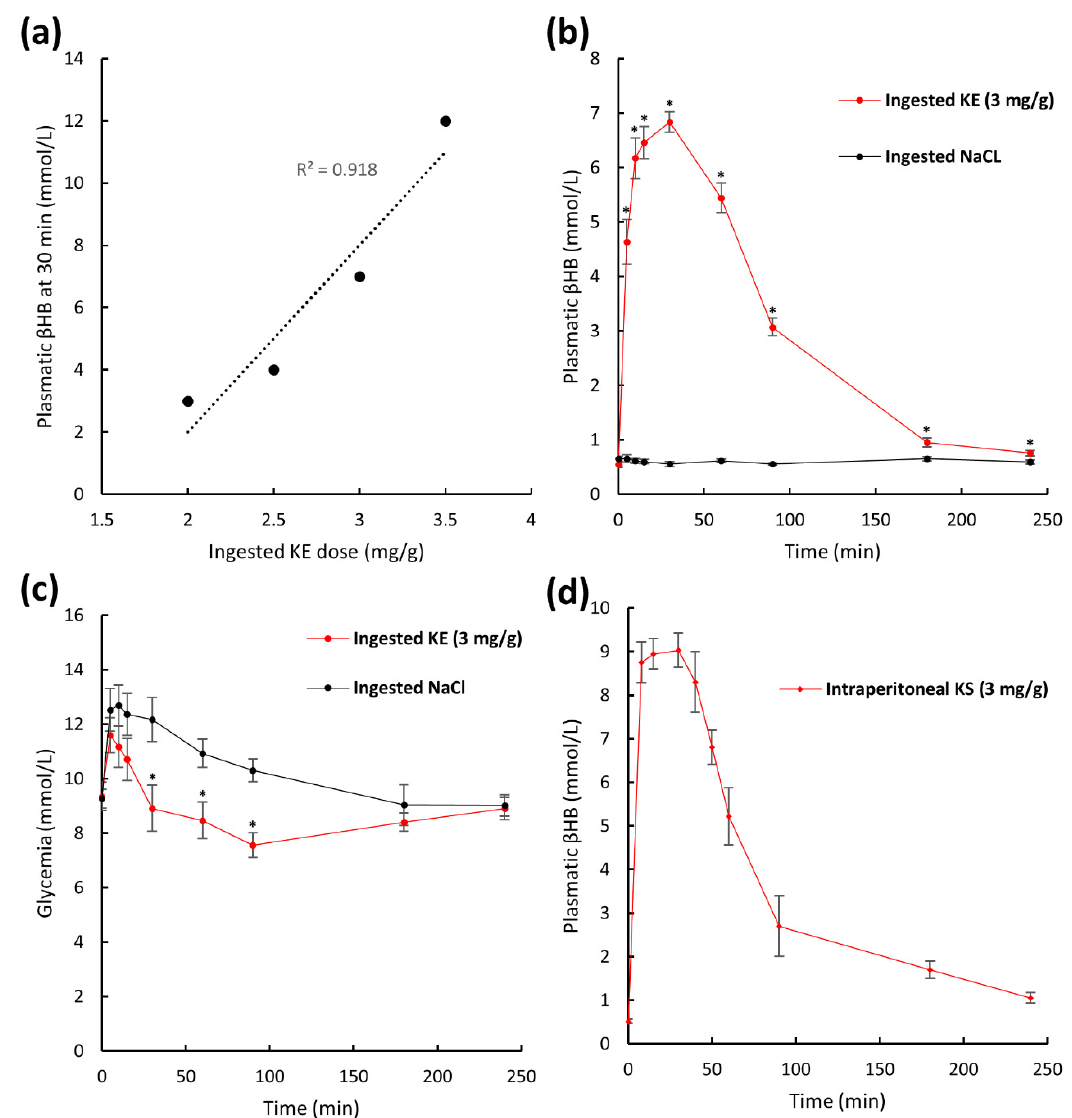
Figure 3. Plasma pharmacokinetics of β -hydroxybutyrate and glucose after KE ingestion. Plasma levels of β HB 30 min after intake of 2, 2.5, 3, and 3.5 mg ketone ester (KE)/g of body weight ( a ). Plasma β HB pharmacokinetics after intake of 3 mg KE/g of body weight or 0.9% NaCl ( b ) and glycemia with the same animals (n = 10) ( c ). Plasma β HB pharmacokinetics of mice after intraperitoneal injection of ketone sodium salt (3 mg KS/g of body weight) ( n = 10) ( d ). * p < 0.05 .